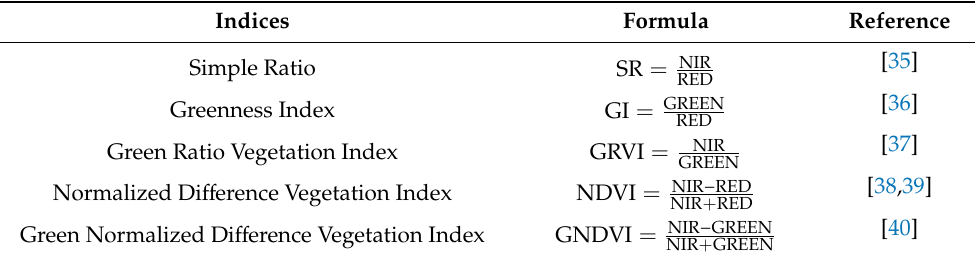
Table 1. Calculated broadband ratio indices with